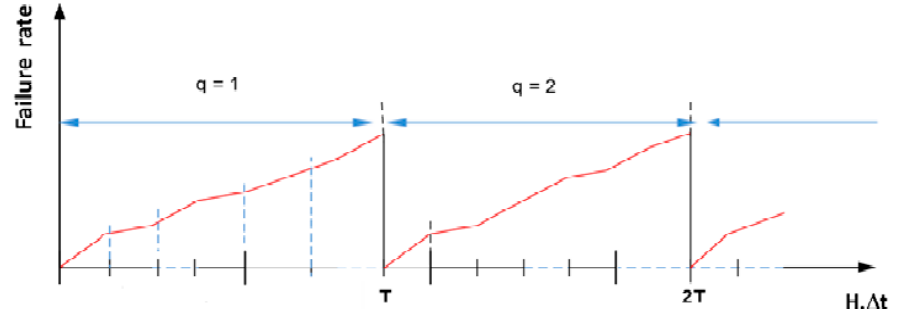
Figure 4. Failure rate evolution.